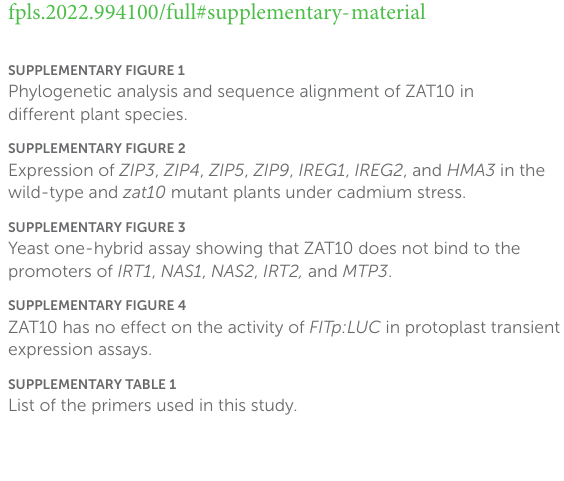
SUPPLEMENTARYFIGURE1 Phylogenetic analysis and sequence alignment of ZAT10 in different plant species. SUPPLEMENTARYFIGURE2 Expression of ZIP3 , ZIP4 , ZIP5 , ZIP9 , IREG1 , IREG2 , and HMA3 in the wild-type and zat10 mutant plants under cadmium stress. SUPPLEMENTARYFIGURE3 Yeast one-hybrid assay showing that ZAT10 does not bind to the promoters of IRT1 , NAS1 , NAS2 , IRT2, and MTP3 . SUPPLEMENTARYFIGURE4 ZAT10 has no effect on the activity of FITp:LUC in protoplast transient expression assays. SUPPLEMENTARYTABLE1 List of the primers used in this